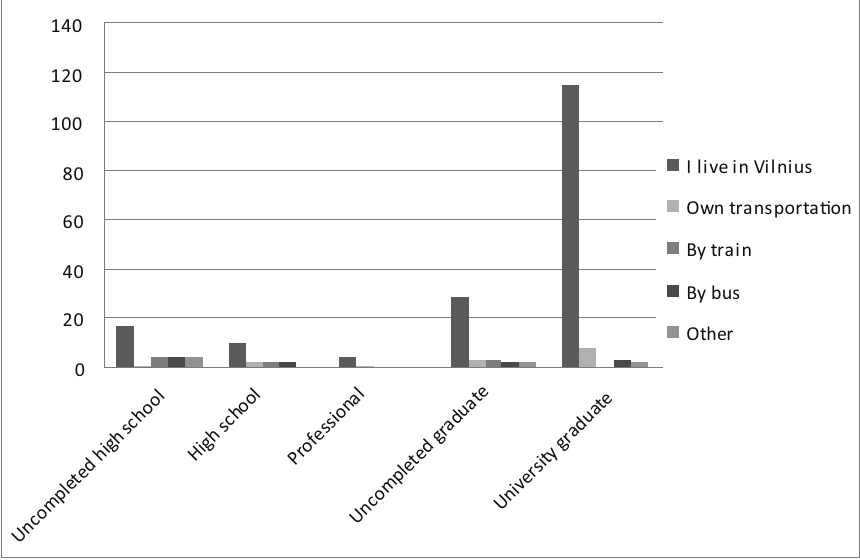
Fig. 15. Channels visitors have found information about the festival